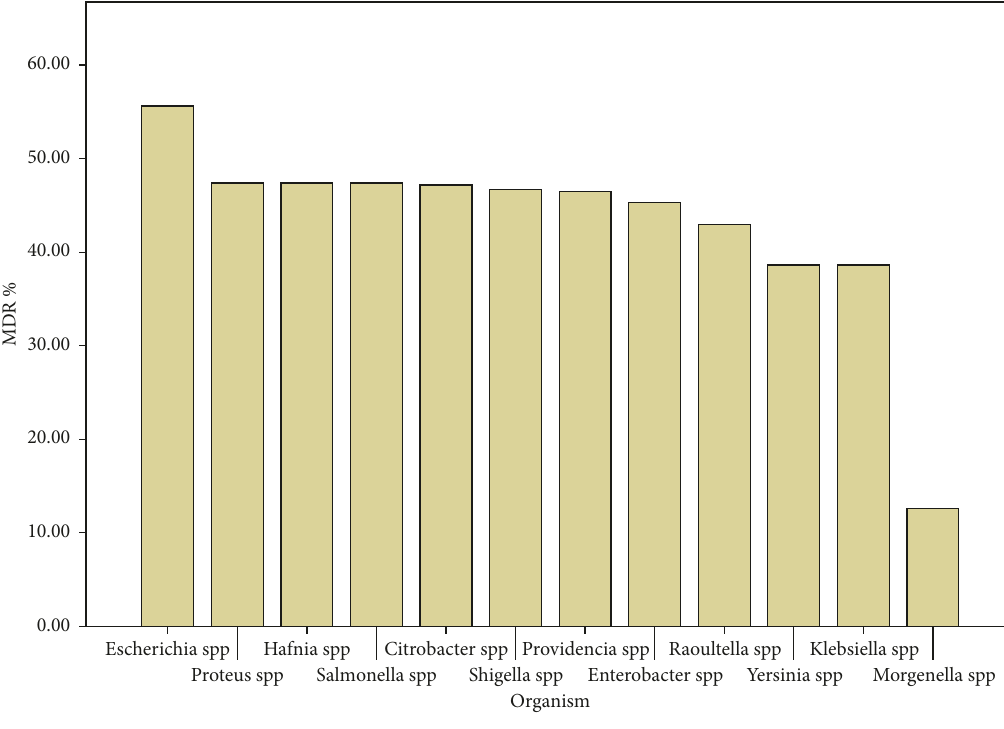
Figure 5: General prevalence of MDR amongst the